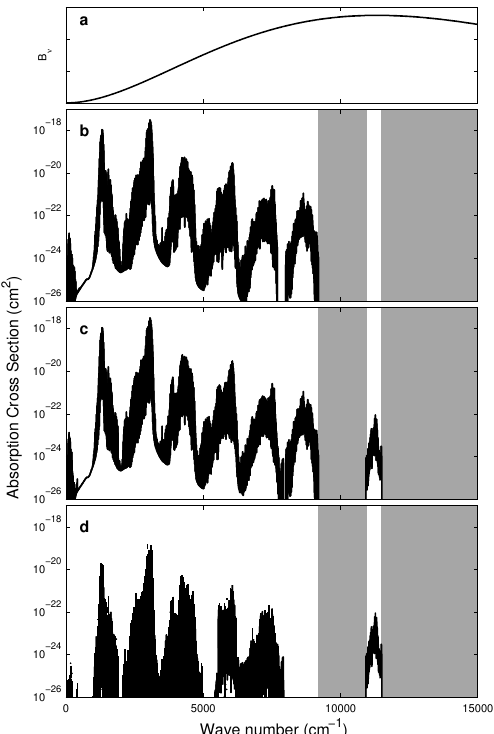
Figure 1. CH 4 solar spectra. (a) Emission spectrum for an object of 5777 K (Effective emitting temperature of modern Sun). (b) HITRAN 2000 and (c) HITRAN 2012 absorption cross-sections for CH 4 . (d) Difference in absorption cross-sections between HITRAN 2012 and HITRAN 2000. Shaded regions indicate where no data exists.